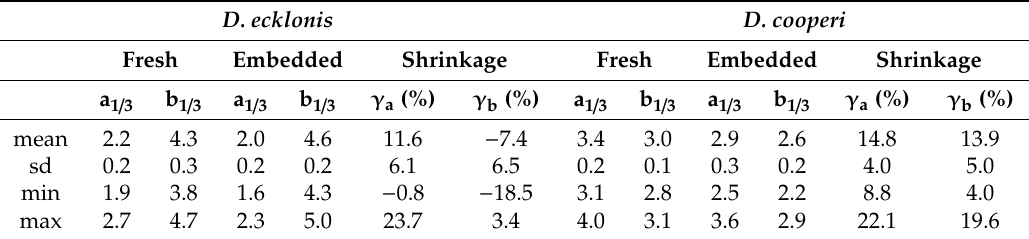
Table A2. Percentage shrinkage ( γ a and γ b in %) along major and the minor radial diameters a and b of the cross-section area of an embedded transverse section relative to the fresh condition of a leaf. The mean values with standard deviations (sd), the minimum (min) and maximum (max) values of the major and the minor radial diameters at the incision region (a 1 / 3 and b 1 / 3 ) and the percentage shrinkage ( γ a and γ b ) for ten samples ( n = 10) are given. Values for the percentage shrinkage of D. cooperi leaves are taken from Klein et al. [15] and given for